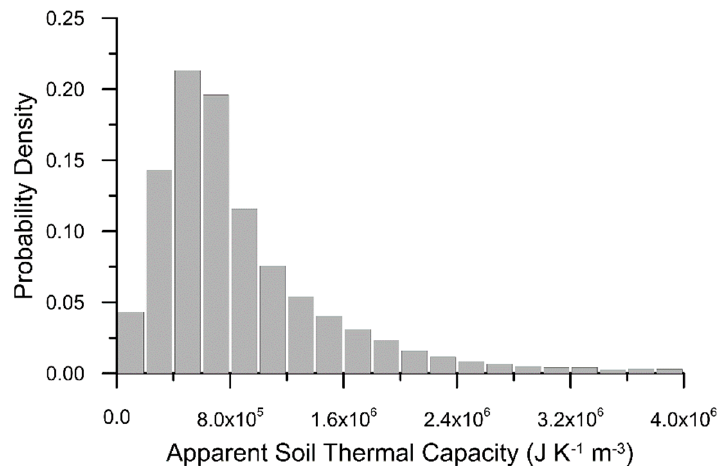
Figure 8. Probability density of soil Apparent Thermal Capacity for TDCs .